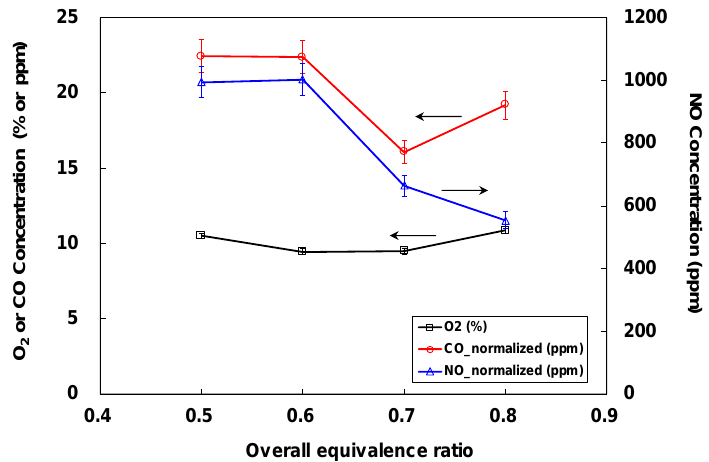
Figure 11. O 2 concentration (%), normalized CO and NO concentrations (ppm) for various overall equivalence ratios at p = 150 kPa and S = 4.56.